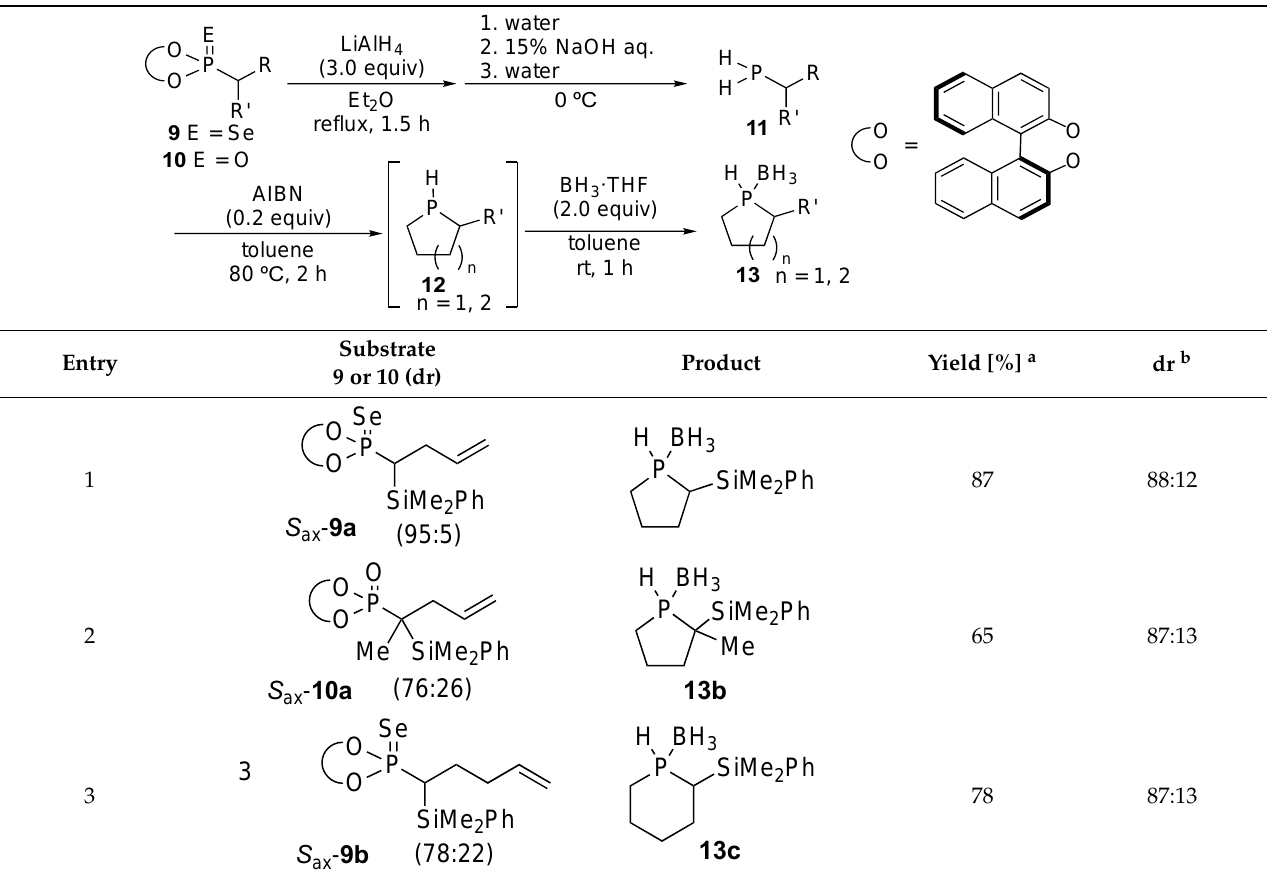
a Isolated yields. b Diastereomric ratio of isolated products determined by 31 P NMR spectra.